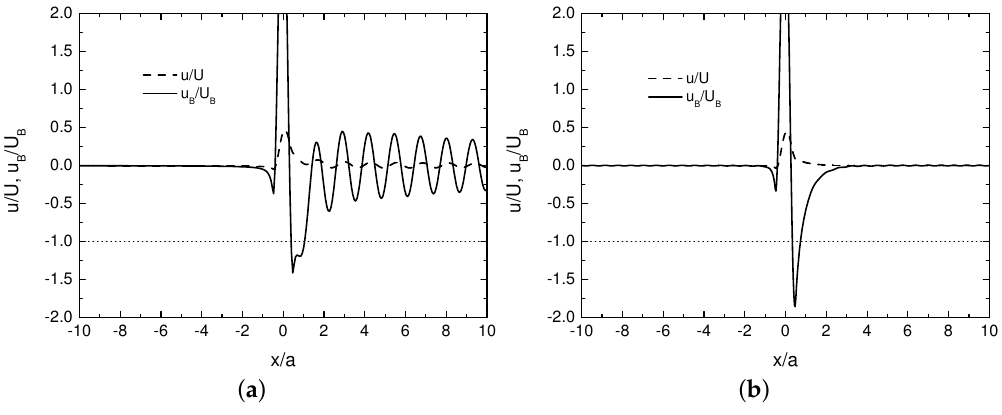
Figure 5. Similar to Figure 2, except that l 2 a = 3.125. ( a ) Fr = 0.6, ( l 2 H ) − 1 = 1; ( b ) Fr = 0.4, ( l ) − 1 = 2 H